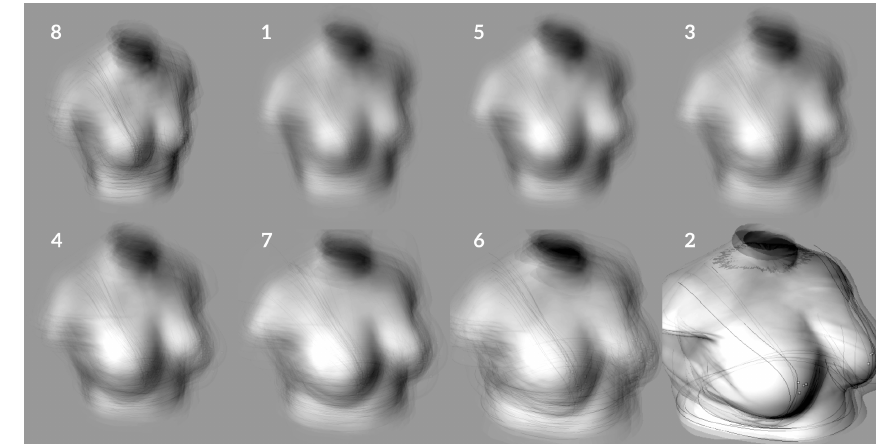
Figure 15. Average images for each cluster, arranged by apparent